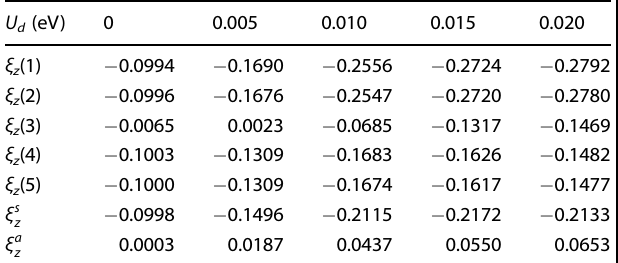
Table 3. Layer resolved valley polarization for the ground